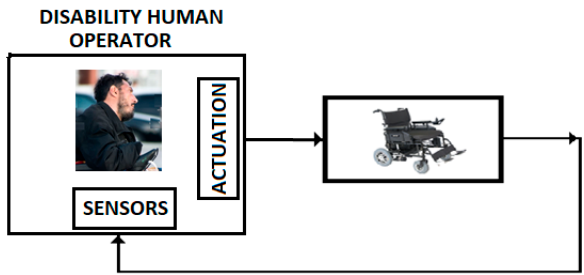
Figure 15. Control with disability human operator.